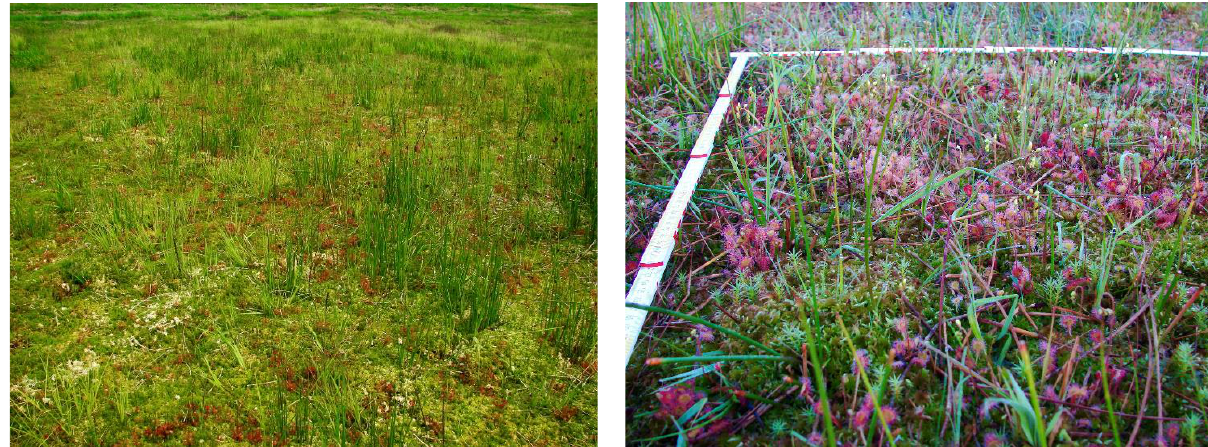
Figure 1. Closed Sphagnum palustre lawn (left) and a random plot with high density of Drosera rotundifolia plants (right) on the Sphagnum palustre field of the Sphagnum farm in Rastede (north-west Germany). Photos: Balázs Baranyai, 16 July 2013.